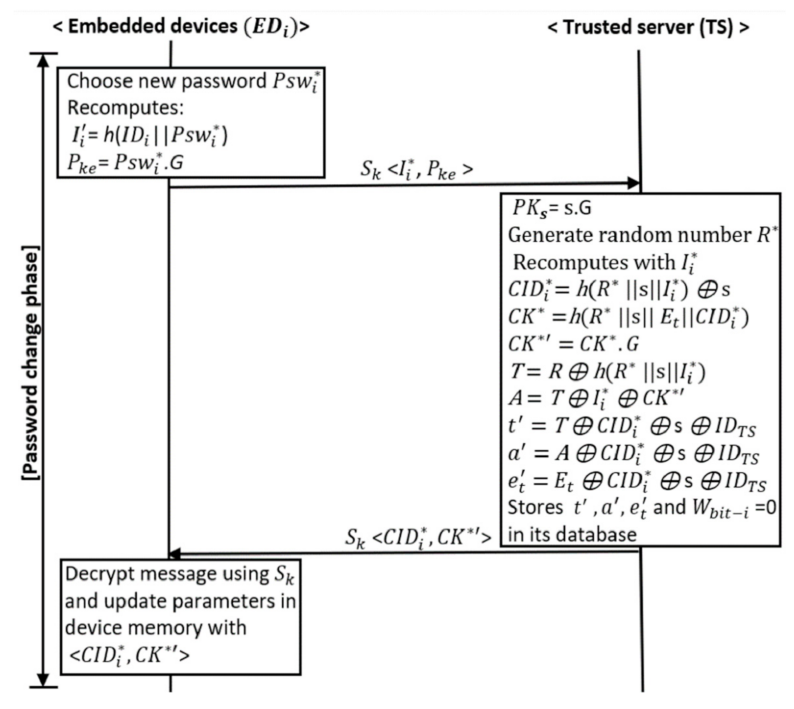
Figure 3. Password-change